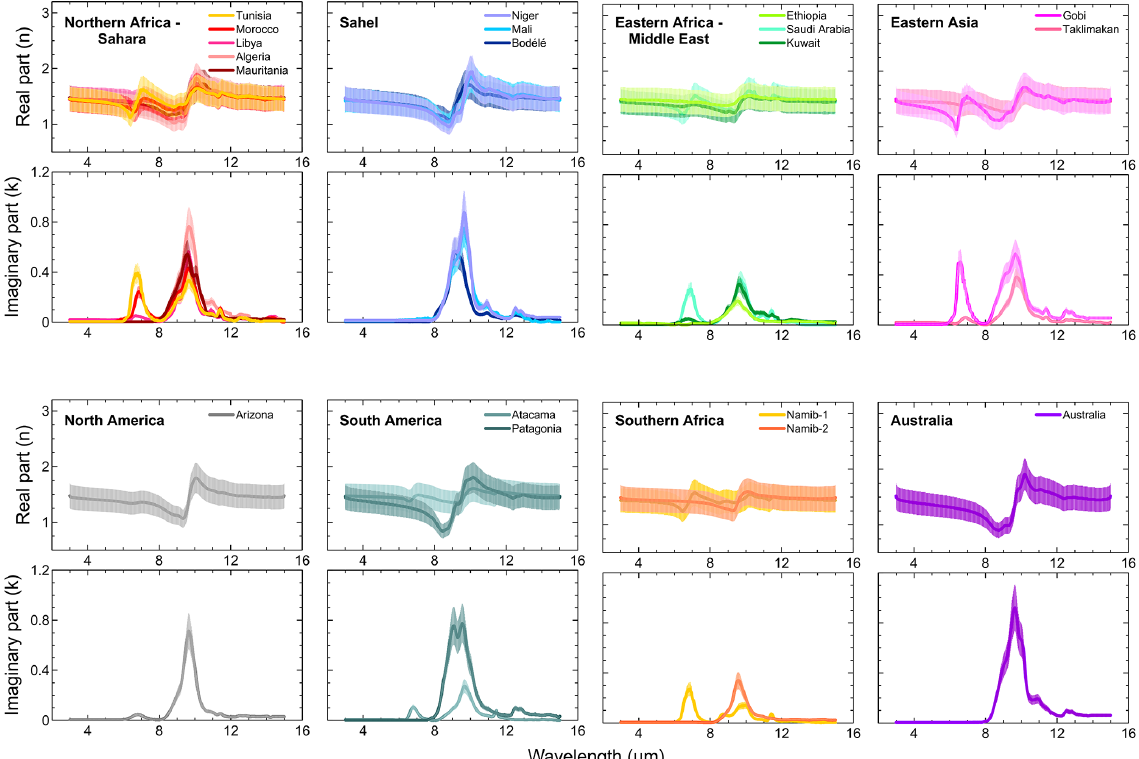
Figure 10. Real ( n ) and imaginary ( k ) parts of the dust complex refractive index obtained for the 19 aerosol samples analyzed in this study. Data correspond to the time average of the 10min values obtained between the peak of the injection and 120min later. The error bar corresponds to the absolute uncertainty in n and k , estimated at ∼±